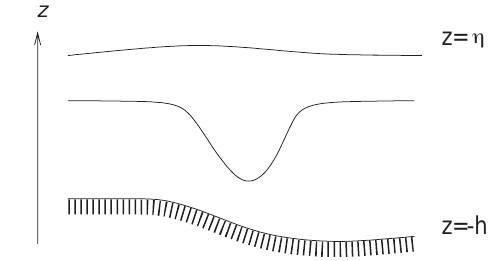
Fig. 1. Coordinate